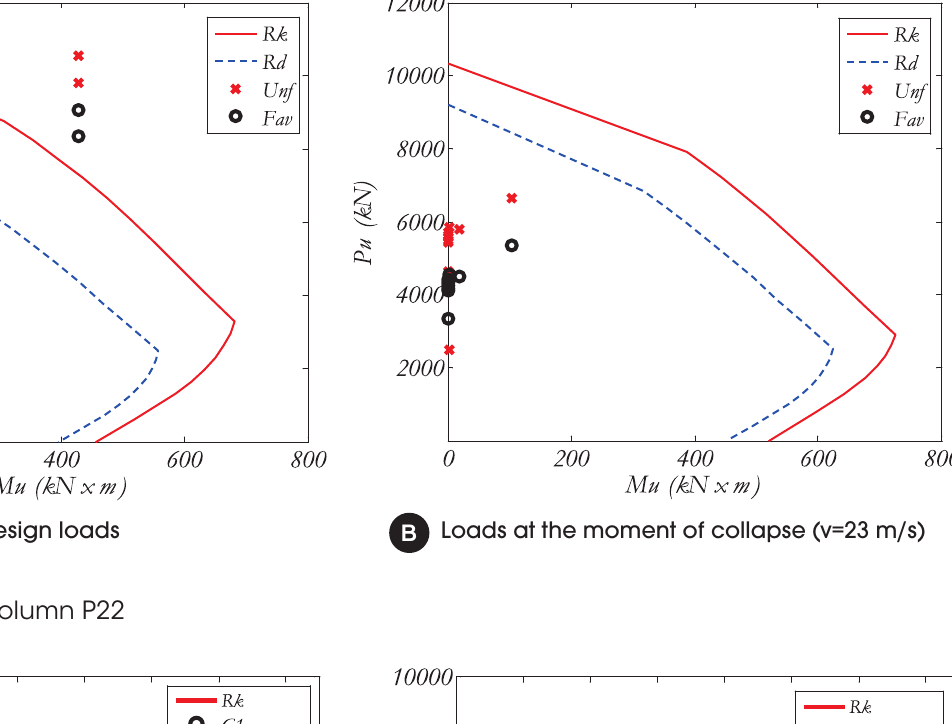
Interaction diagram of column P22